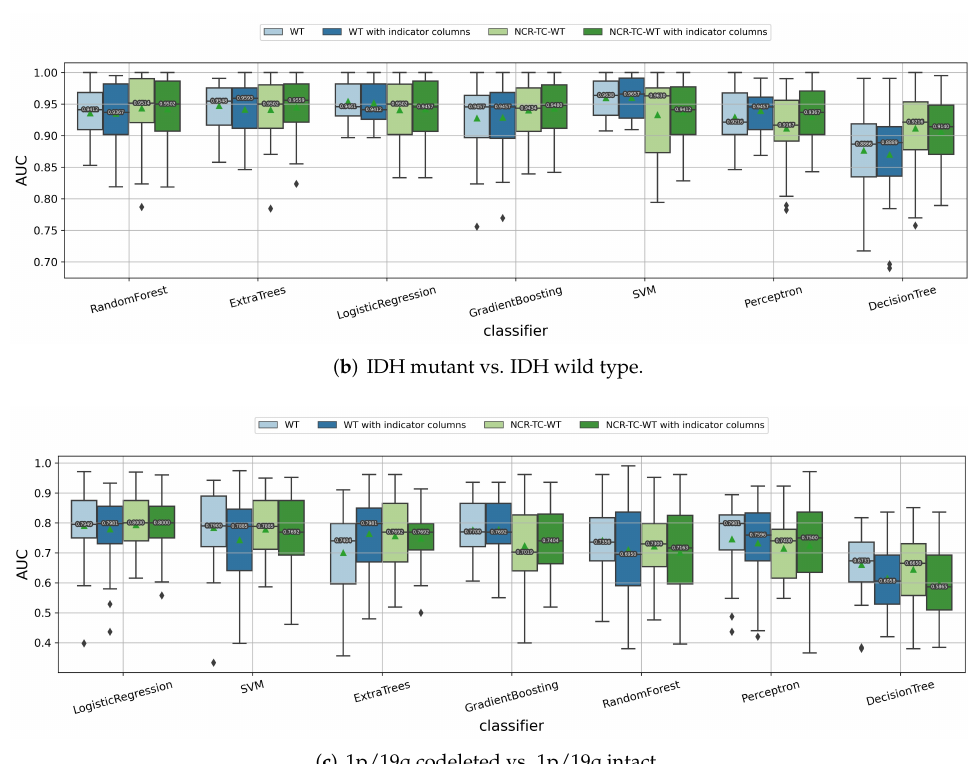
Figure 4. Impact of different feature extraction strategies on predicting ( a ) tumor grade, ( b ) IDH mutation status, and ( c ) 1p/19q codeletion status. WT means using the radiomic features extracted from the whole tumor, and NCR-TC-WT means using features extracted from three subregions including necrosis, tumor core, and whole tumor. “With indicator columns” means two indicator columns are included as additional features to tell whether the glioma tumor has ED or ET parts.